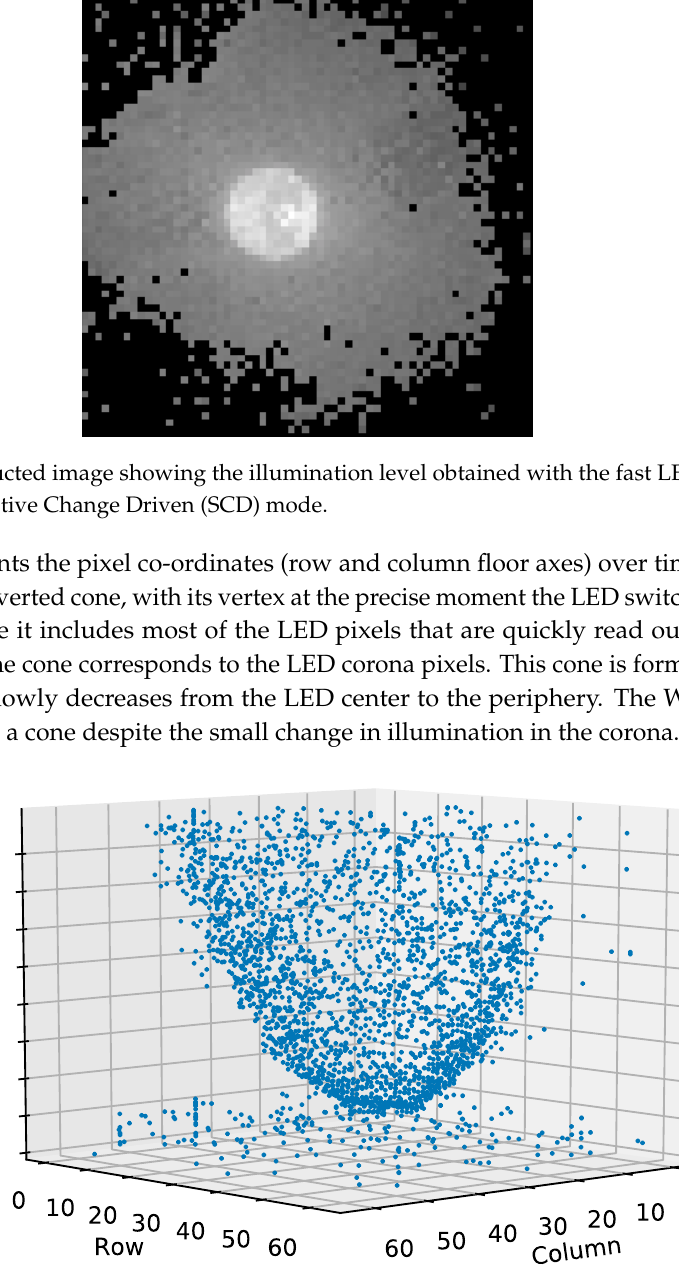
Figure 10. Three-dimensional representation of pixel co-ordinates (row and column) over time. Event occurs at 0.560 ms.